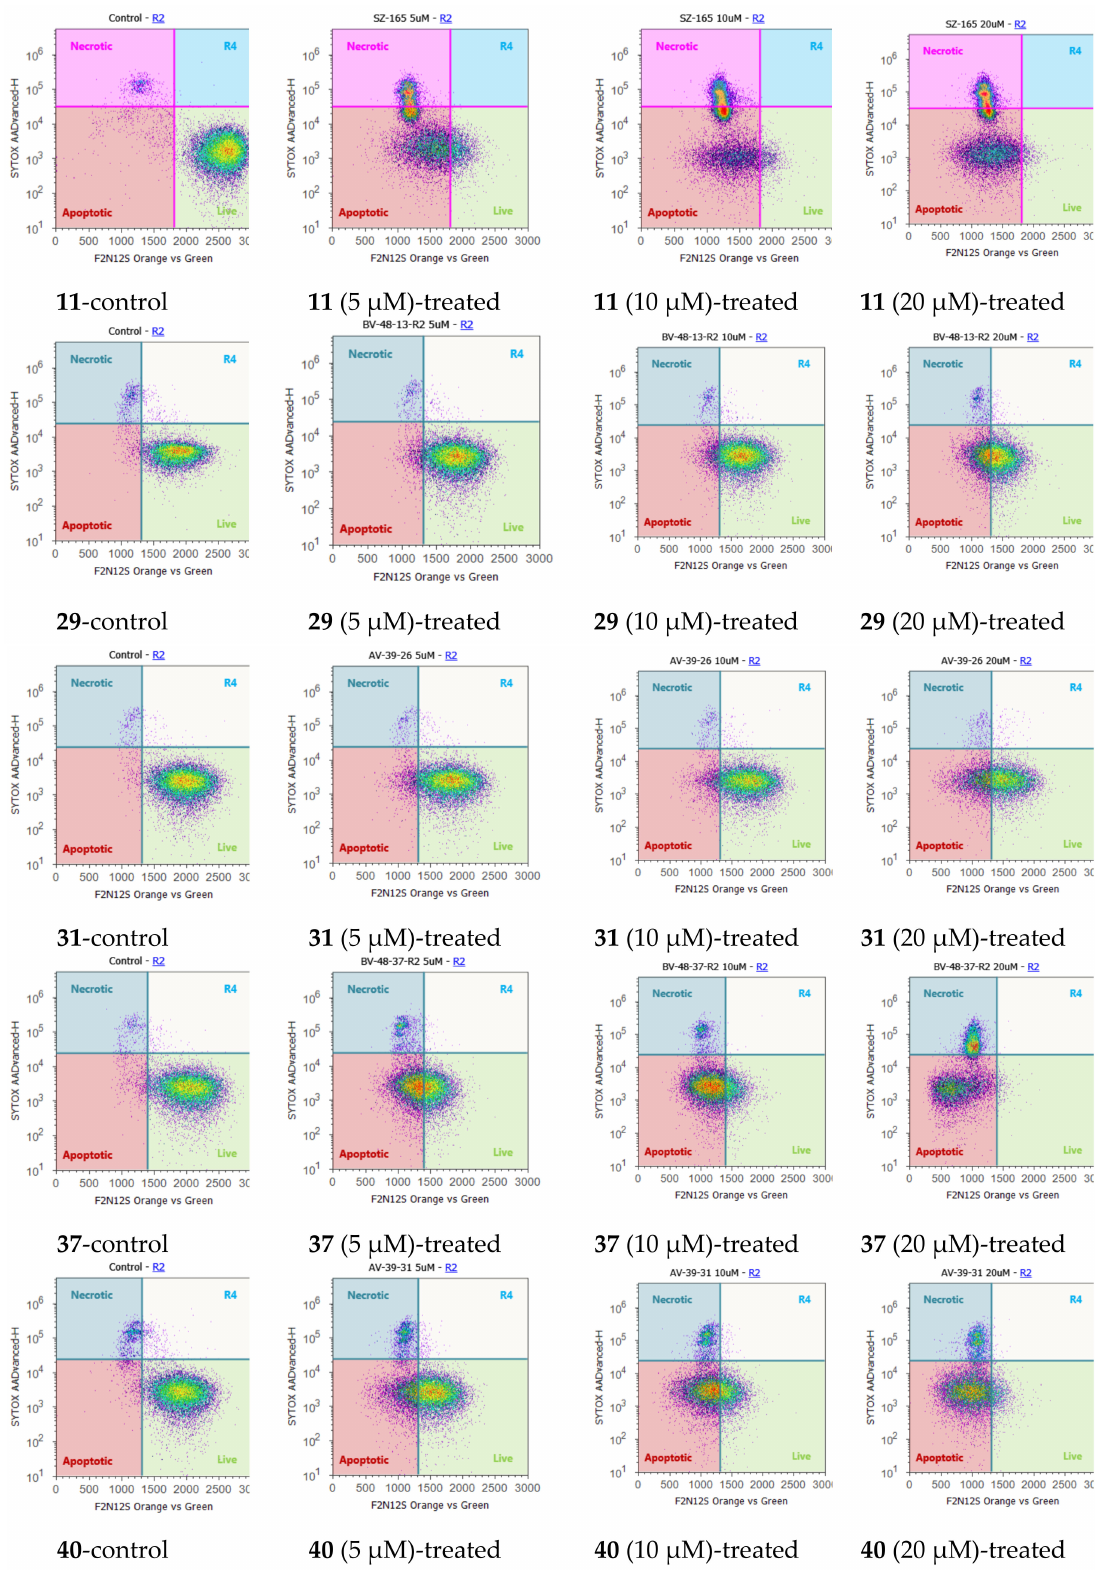
Figure 2. Apoptosis in PC-3 cells treated with 11 , 29 , 31 , 37 , and 40 at 5 µ M, 10 µ M, and 20 µ M (by F2N12S and SYTOX AADvanced double